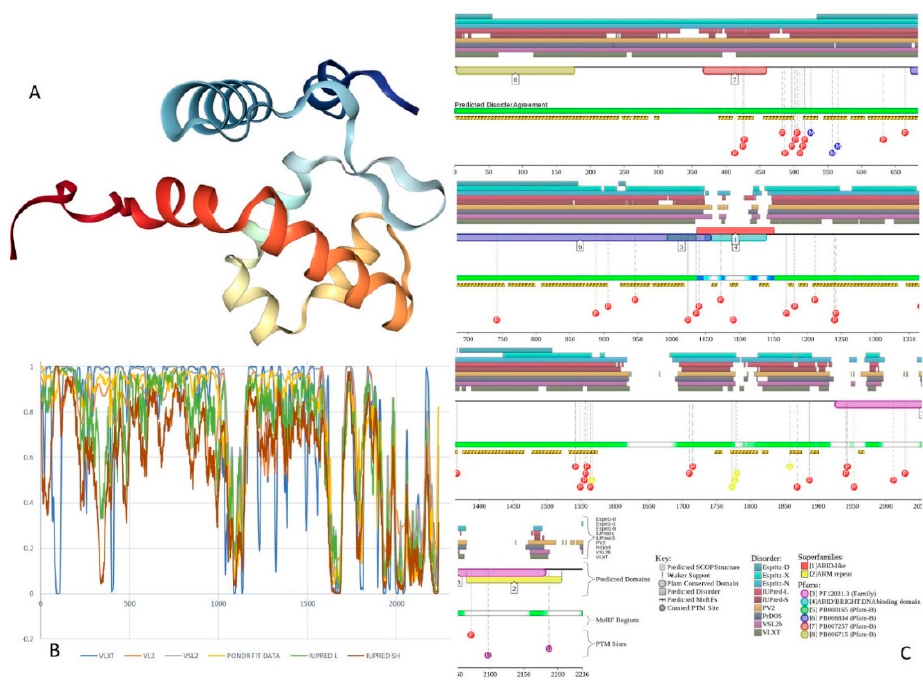
Figure 11. Structural organization of the human BAF250B protein. ( A ) X-ray crystal structure of the ARID domain (residues 1041–1159; PDB ID: 2CXY). ( B ) Intrinsic disorder profile of human BAF250B protein (UniProt ID: Q8NFD5) generated by six commonly used predictors of intrinsic disorder (PONDR ® VLXT, PONDR ® VL3, PONDR ® VSL2, PONDR ® FIT, IUPred_short, and IUPred_long). ( C ) D 2 P 2 functional disorder profile of the human BAF250B protein.